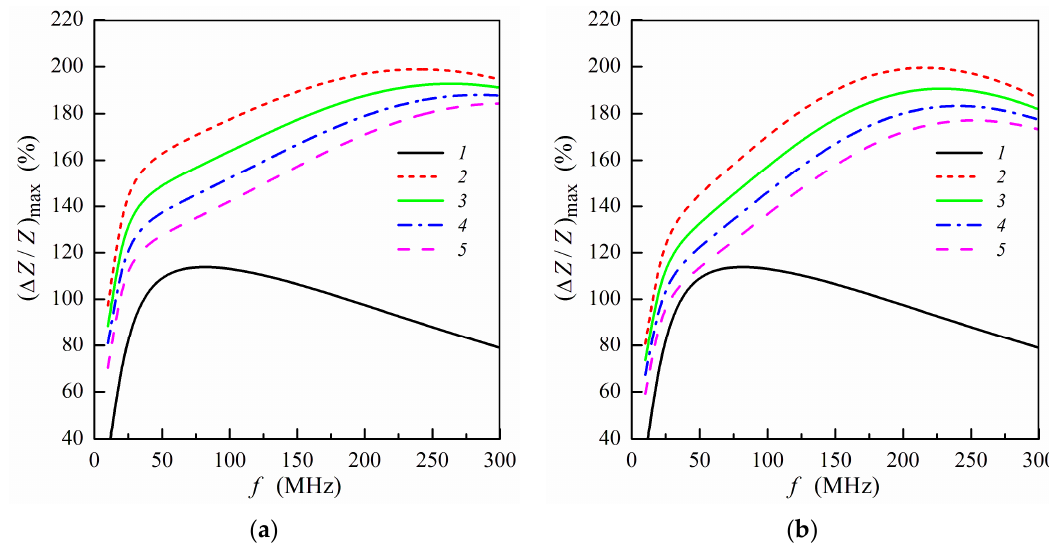
Figure 4. Frequency dependence of maximum MI ratio ( ∆ Z / Z ) max for the multilayered sensitive element with ferrogel placed onto the surface of thin layer ( m = 3, n = 4) ( a ) or onto the surface of thick layer ( m = 4, n = 3) ( b ) (see also Figure 1e,f). Curves 1 correspond to the multilayered film without gel; curves 2, film with pure gel (hydrogel) ( H p = 0); curves 3 H p = 0.25 Oe; curves 4, H p = 0.5 Oe; curves 5, H p = 0.75 Oe. Other parameters used for calculations are the same as in Figure 2.